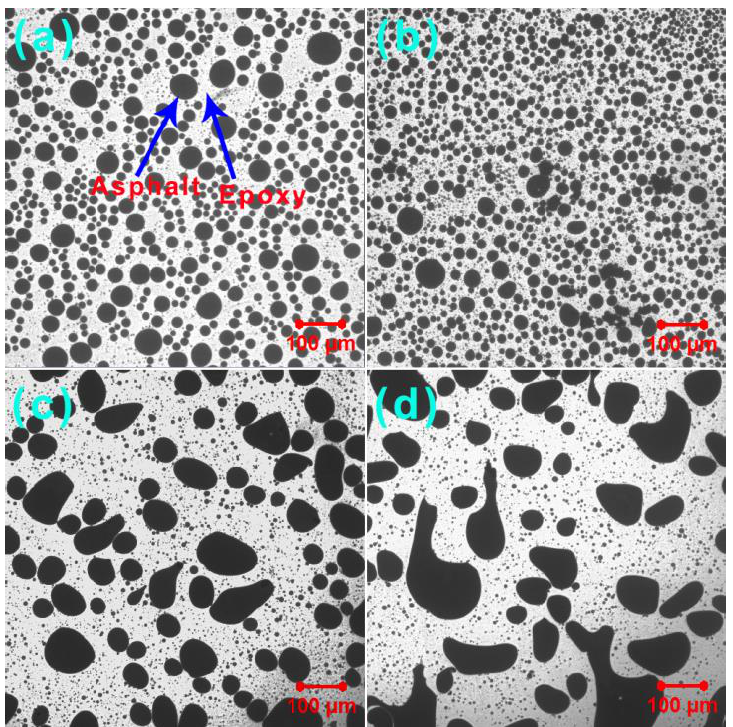
Figure 11. Transmittance confocal microscopy photographs of the unmodified EABC ( a ) and GO- modified EABCs: 0.2 wt% ( b ), 0.5 wt% ( c ) and 1.0 wt% ( d ). Table 4. Average diameters and PDIs of dispersed asphalt domains in the unmodified and GO- modified